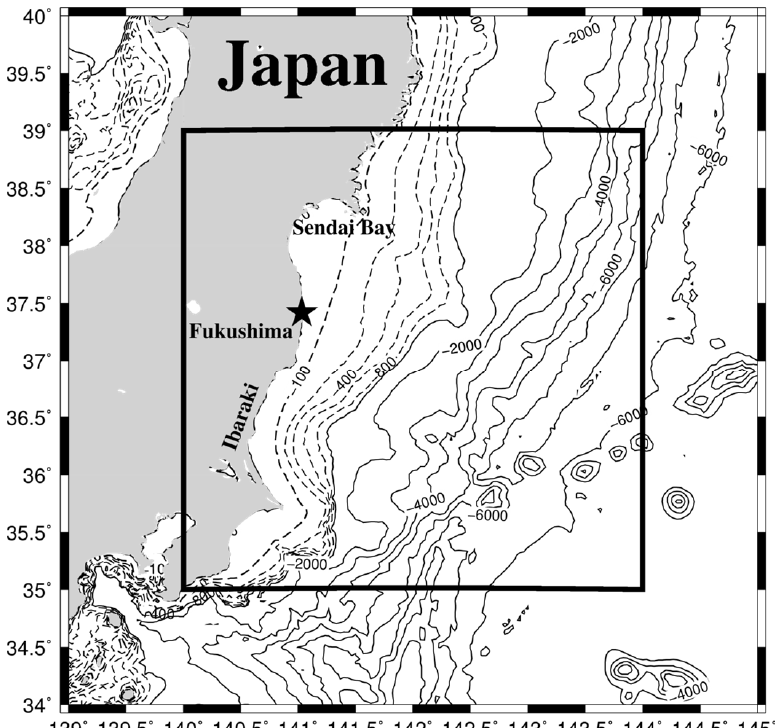
FIGURE 1: Bottom topography of the region close to the FNPP. Contours are drawn for 100, 200, 400, 600, 800, 1000m, and every 1000m after that. Black star indicates the location of the FNPP. Model domain is the squared region surrounded by the thick black solid line. The continental shelf break, which can be roughly interpreted from the 200m contour line, is located close to the coast near Ibaraki but further off-shore near Fukushima.